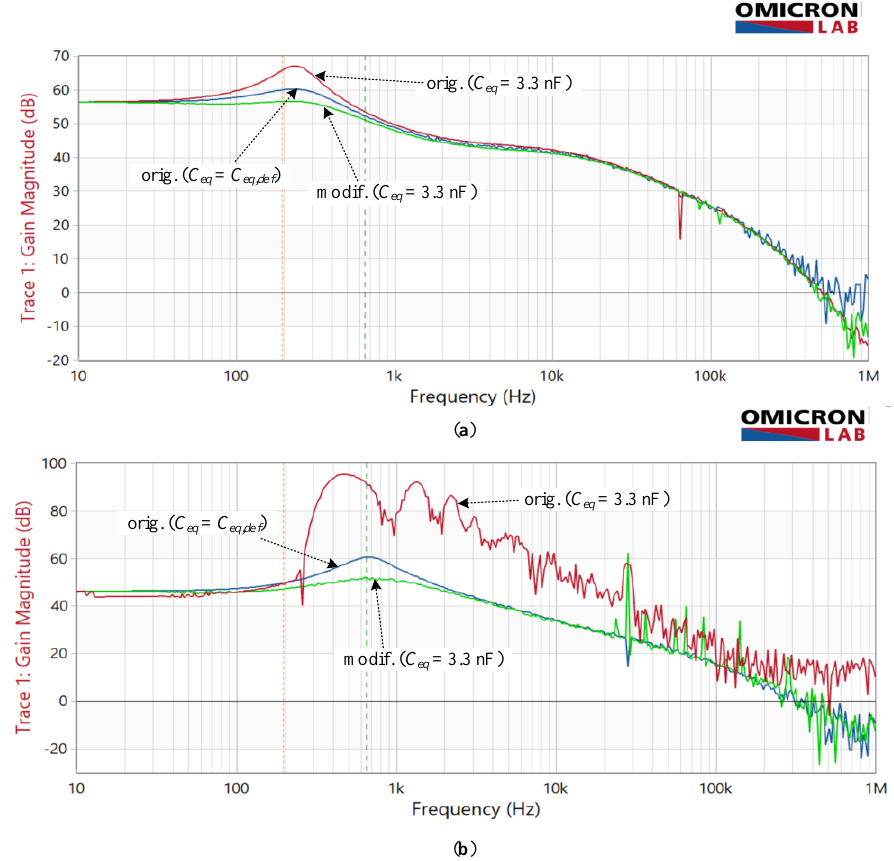
Figure 13. Measured frequency response Y with original and modified amplifier in regard to C eq : ( a ) optimized Comp 2 ; ( b ) non-optimized Comp 2 .